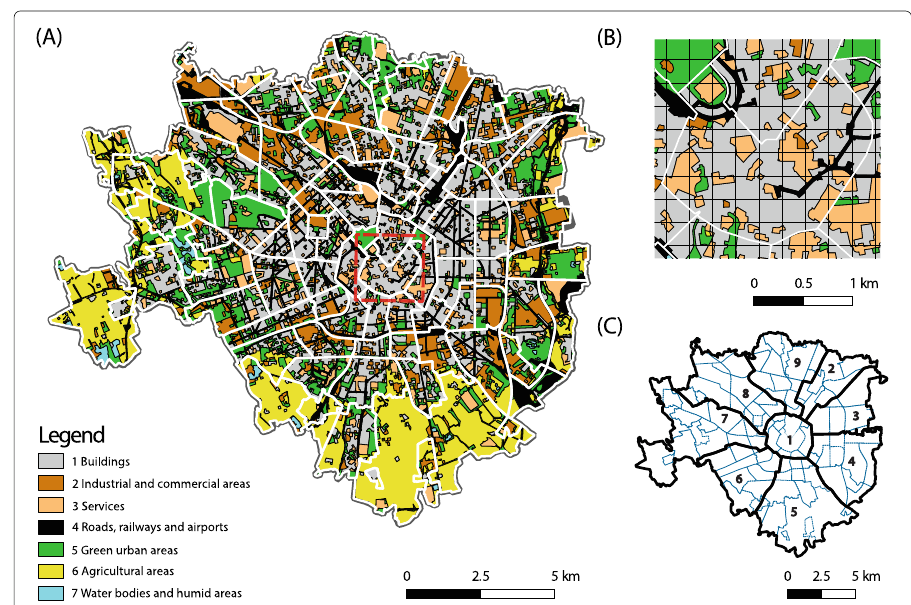
Fig. 1 Land use distribution in the city of Milan. a The spatial distribution in the city of Milan of the seven land uses (see legend and definitions in the main text). White lines design the borders of the 88 NILs ( Nucleidi IdentitàLocale , see text). b A zooming on the city center shows the grids over which CDR data was recorded. c Administrative subdivision of the city: the 9 Boroughs (Municipi) of Milan and their NILs are contoured by black (thick solid) and blue (dashed lines),